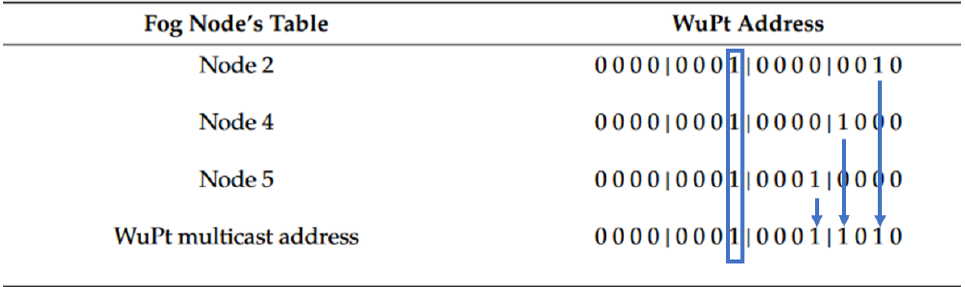
Figure 5. Example of forming the multicast wake-up